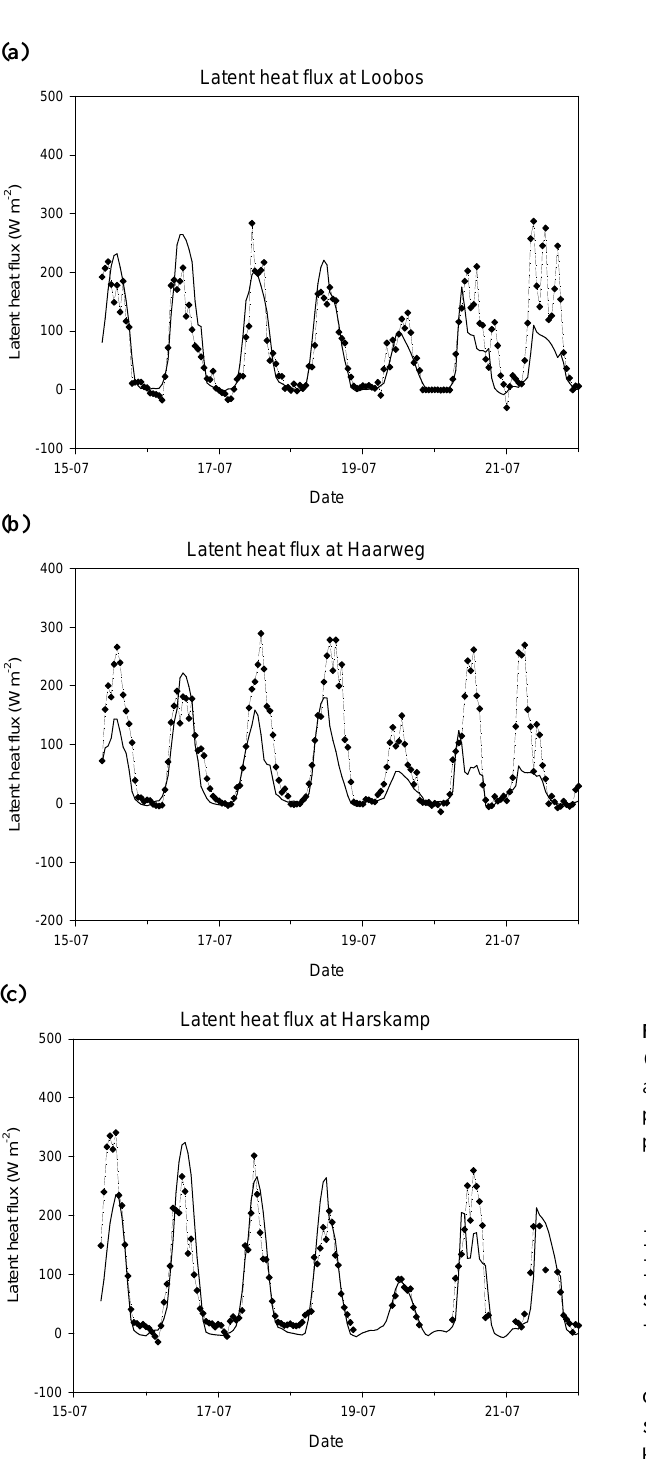
Fig. 8. Comparison of observed and simulated latent heat fluxes (Wm − 2 ) for Loobos – (a) forest site – Wageningen – (b) grass site – and Harskamp – (c) maize site. Diamonds and dotted lines: ob- served values; black lines simulated at a gridpoint nearest to the observational site and representing the appropriate tile.